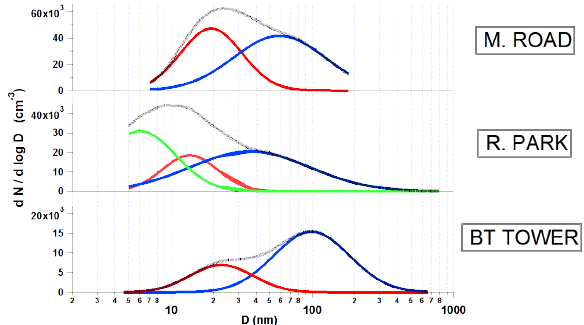
Fig. 4. Measured size distributions from Fig. 3 expressed as com- binations of component log normal distributions. Please note dif- ferent y-axes for the 3 different sites (60, 40 and 20000cm − 3 for M. Road, R. Park and BT Tower,